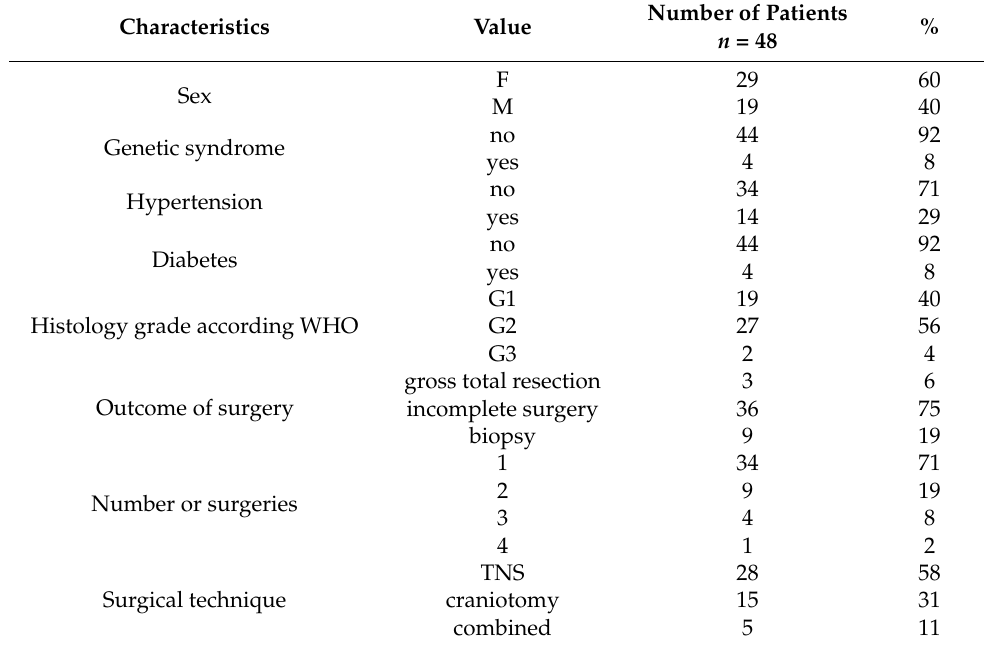
Table 1. Characteristics of